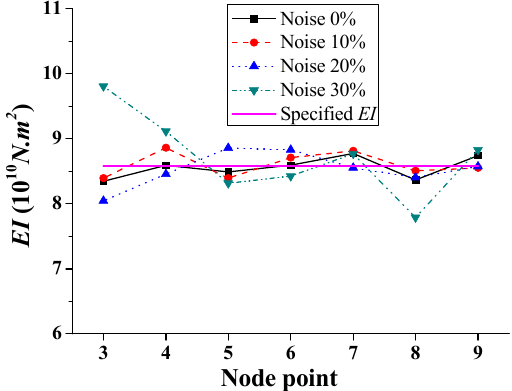
Figure 16. Simulation results of calculated EI with different noise levels.